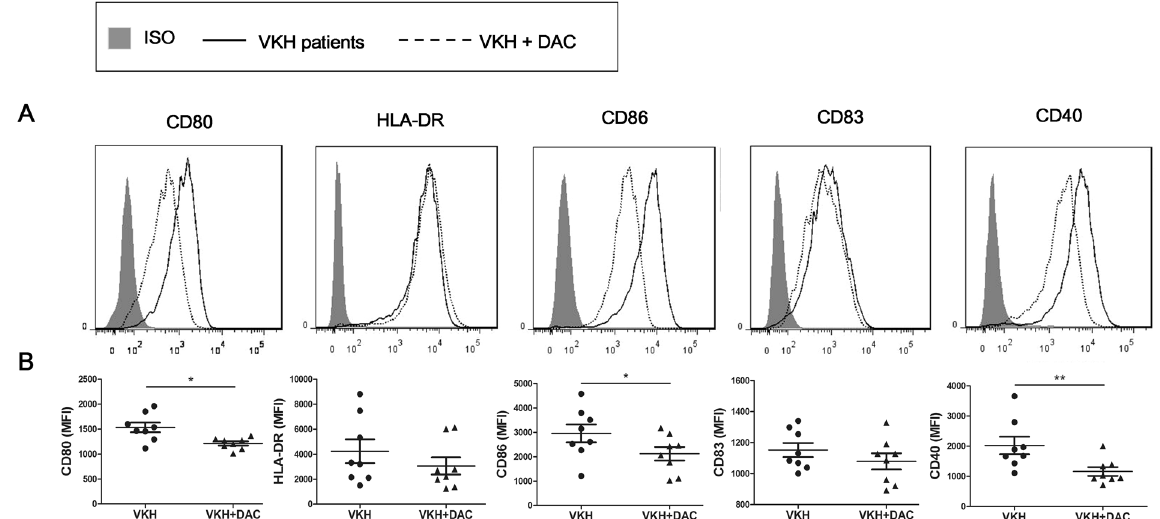
Figure 5. DAC reduces the expression of surface markers of DCs from VKH patients. Immature DCs from VKH patients were cultured with or without the presence of DAC for 6 days, then followed by stimulation with 100 ng/mL LPS for 24 hours. DCs were subsequently harvested for flow cytometry analysis with specific surface antibodies against CD80, HLA-DR, CD86, CD83 and CD40. ( A ) Histograms with overlays are from representative experiments of DAC treated and untreated DCs from VKH patients. ( B ) Mean fluorescence intensity (MFI) of surface markers on DAC treated and untreated DCs from VKH patients. Data are shown as mean ± SEM. Statistical analysis was performed using the paired-samples t-test (n = 8, * p < 0.05; ** p < 0.01).